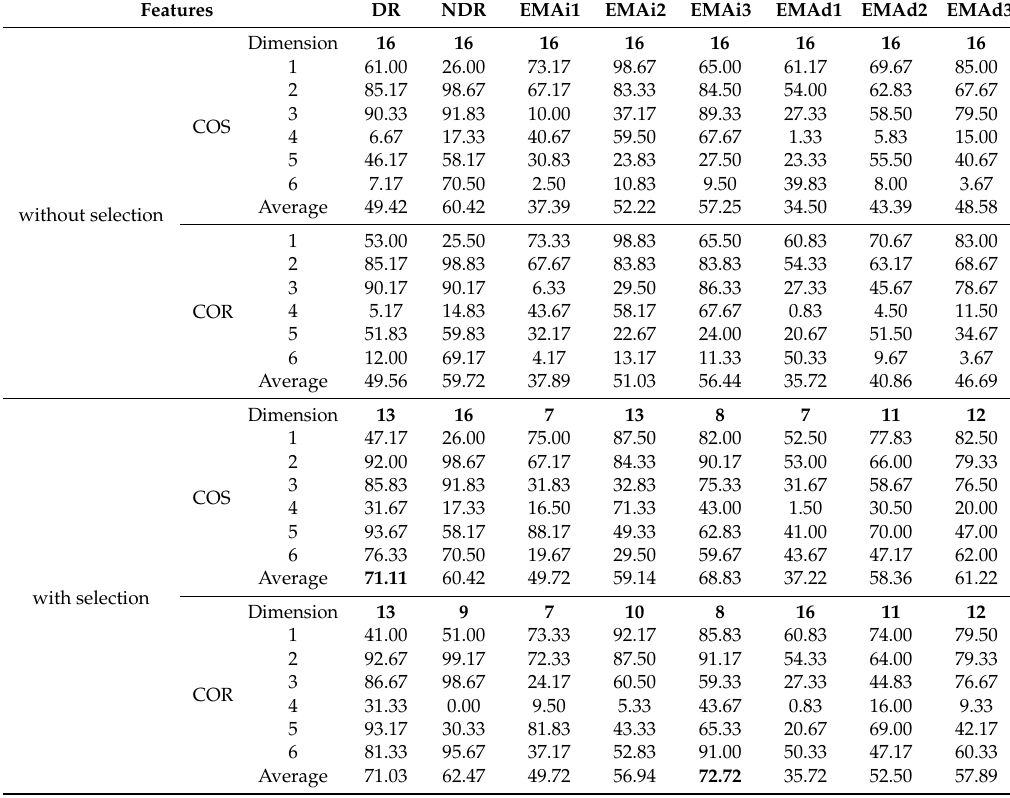
Table 10. Classification accuracy of Dataset II with/without feature